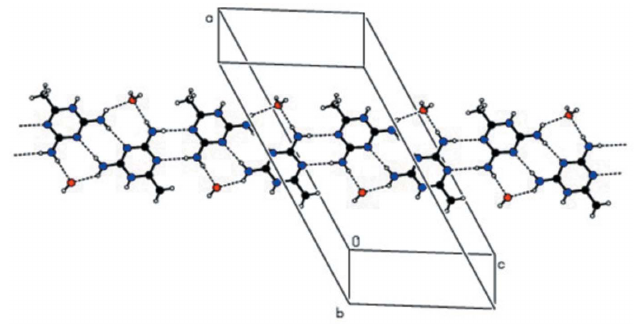
Figure 3 Another view of the extended chains with the TCA anions omitted, showing the DADA array and the participation of the water molecules in hydrogen